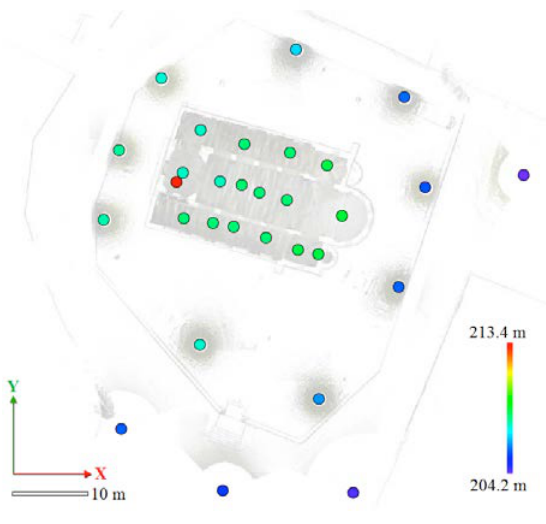
Figure 4. Locations of scans in an overview map 13 scans were realized outside the church and 17 scans were realized inside the church. A density of one point every 6 mm at 10 metres was chosen except for a scan located in the centre of the church for which a density of one point every 3 mm was chosen.